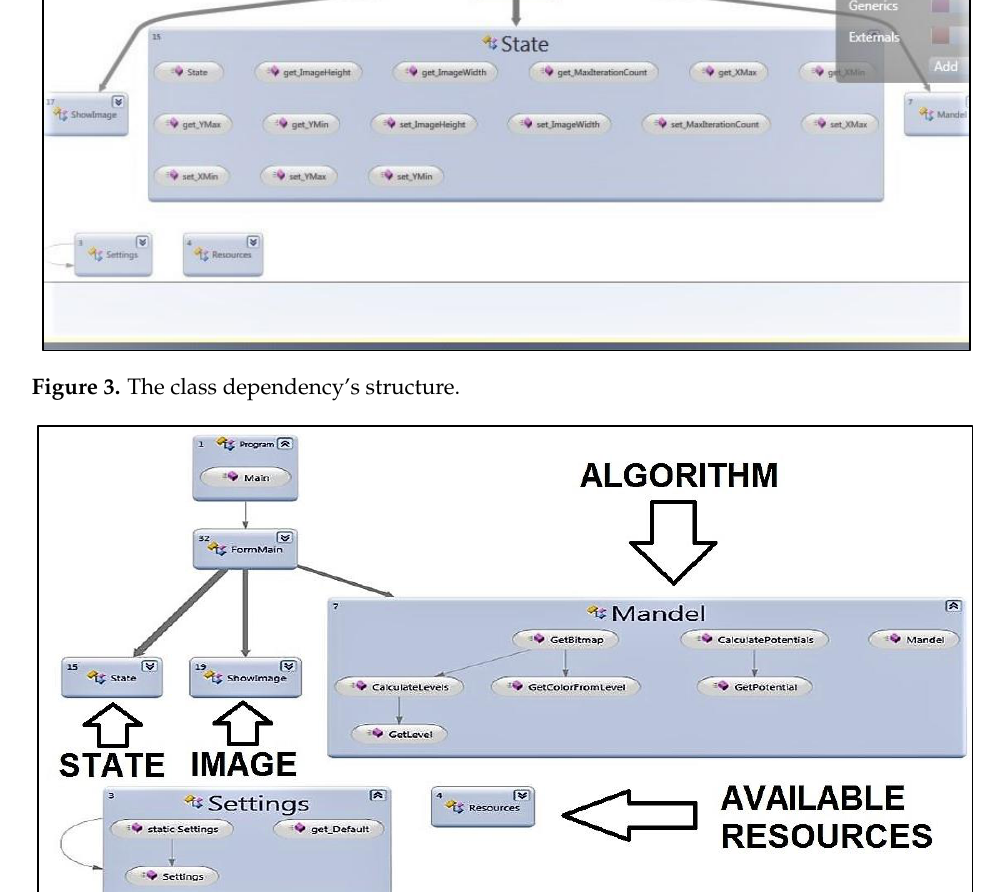
Figure 4. Mandelbrot Class Architecture — Main class.